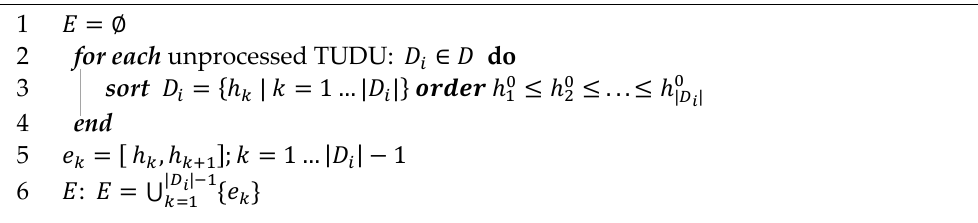
Figure 8. Construction of edges of individual TUDUs. Algorithm 3. Formation of edges between neighbouring TUDUs. Figure 7. Illustration of algorithm used for the formation of vertices. Algorithm 2. Construction of edges within one TUDU. Algorithm 2: Construction of edges within one TUDU.